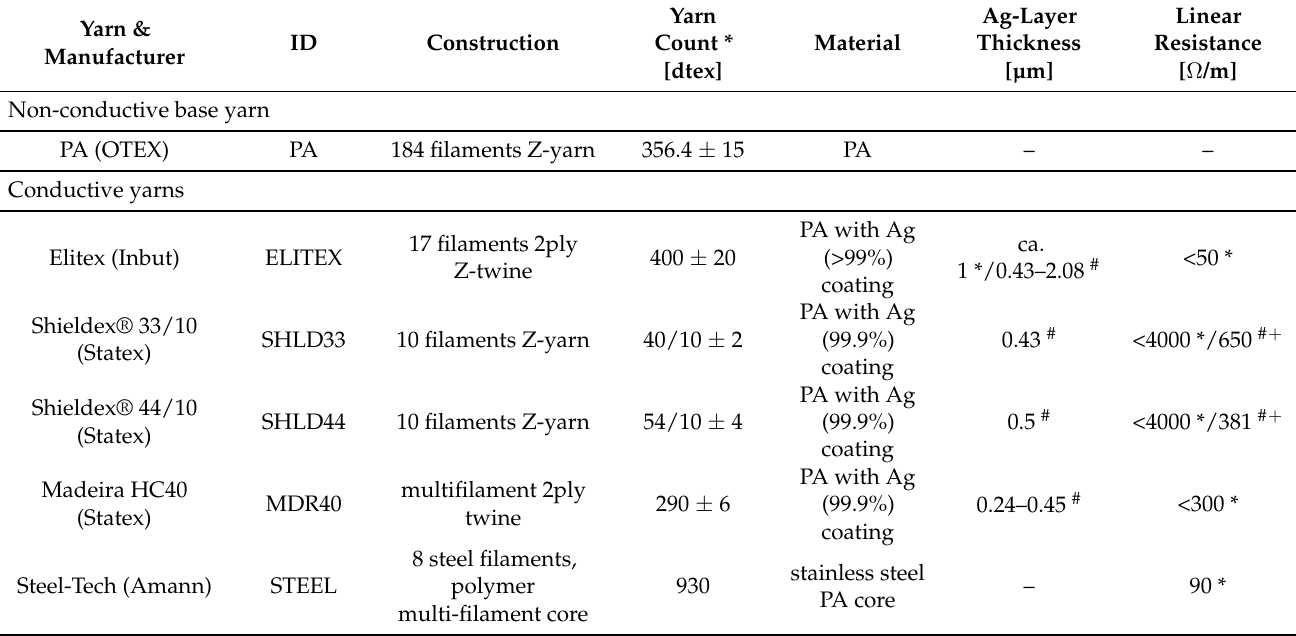
Table 1. Properties of utilized